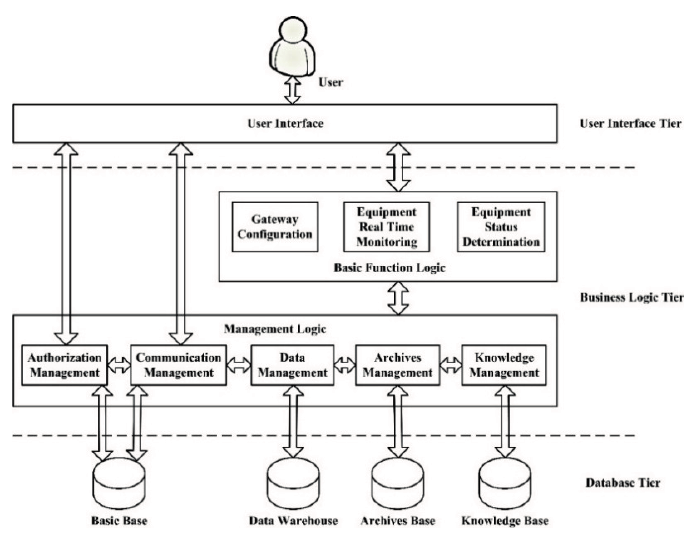
Figure 7. RIMS system